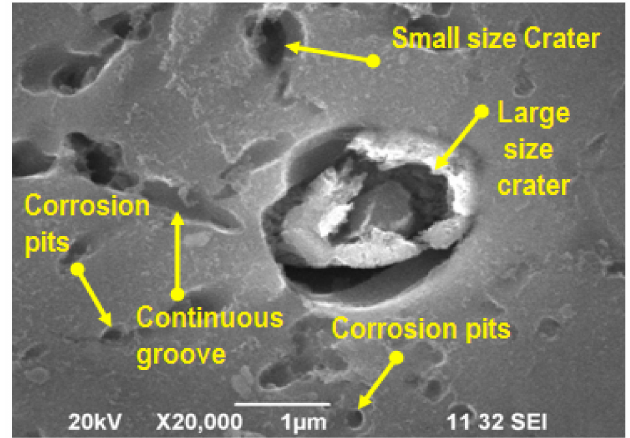
Figure 35. SEM image of corrosion